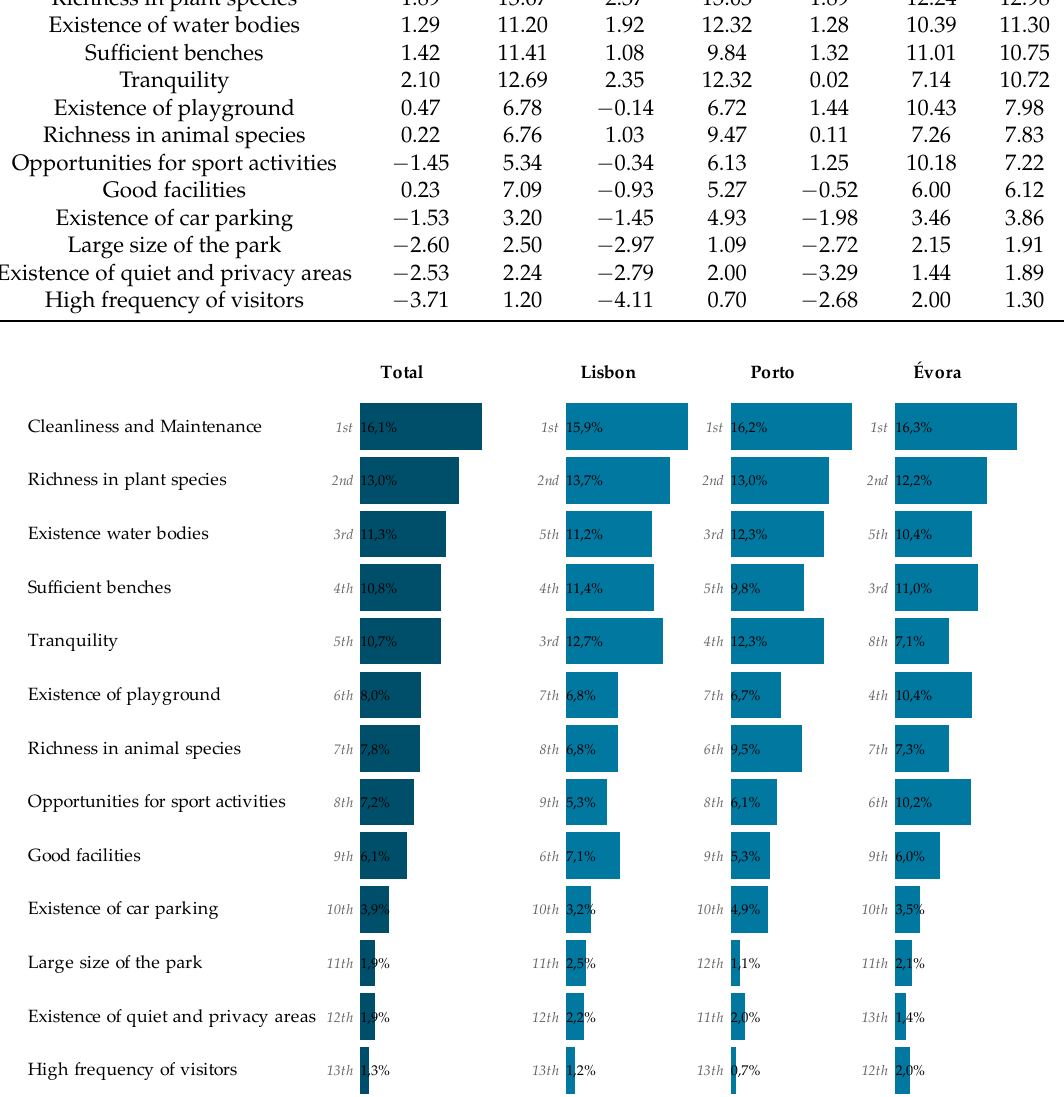
Figure 2. Rescaled Scores for the green spaces characteristics evaluated by respondents from Lisbon, Porto and Évora. Scores are ordered according to global results.